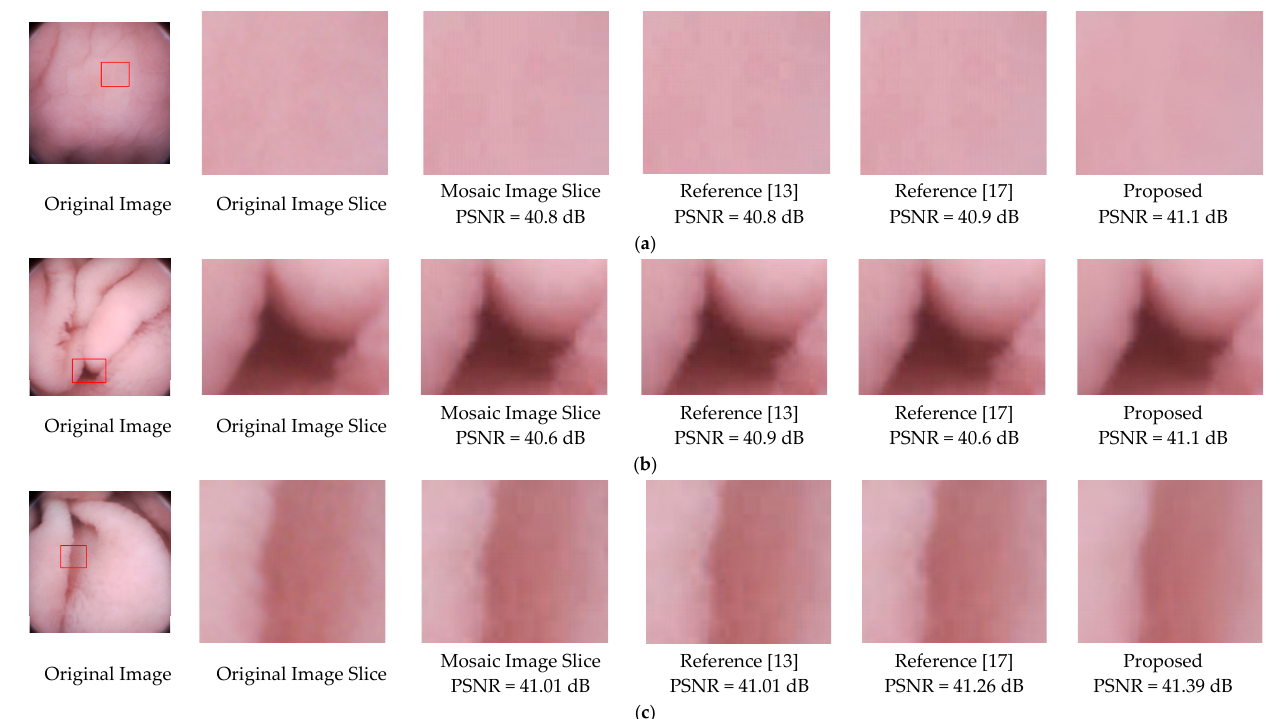
Figure 13. Deblocking performance comparison of References [13,17] and the proposed method. ( a ) is relatively flat, ( b ) are images with folds or vessels, ( c ) has rich villi. Note that regions with a size of 70 × 70 are sliced from the original images, and the methods were performed on the same mosaic images.